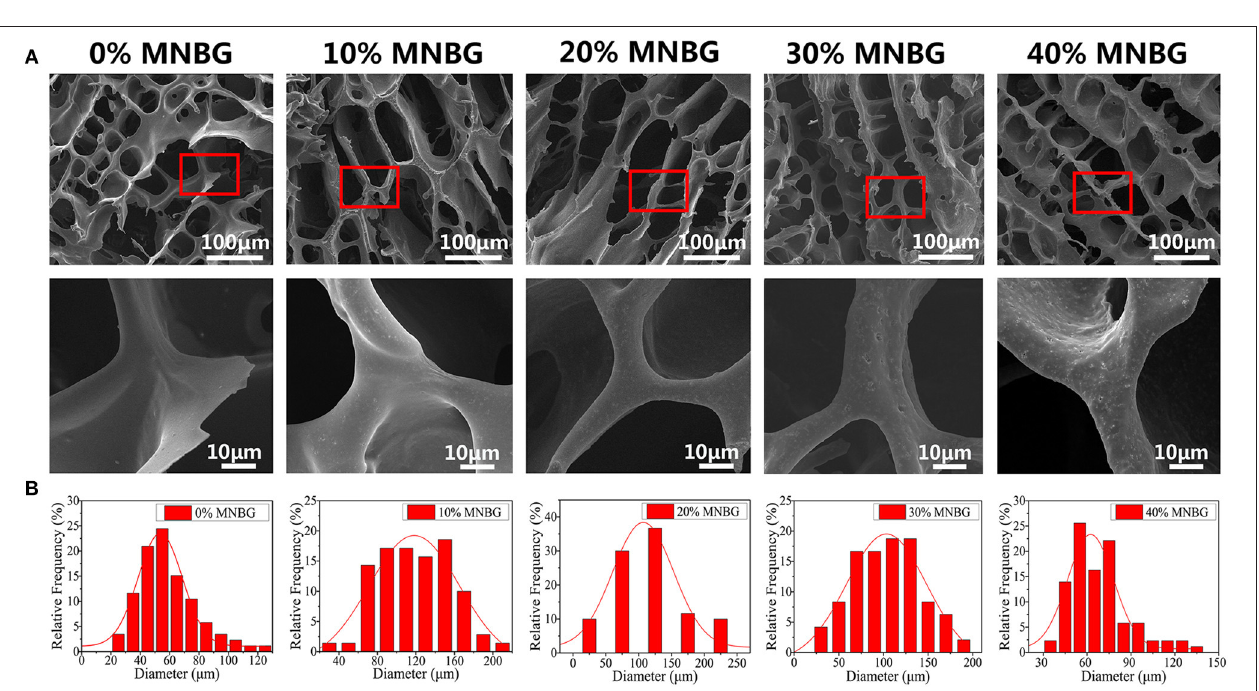
FIGURE 2 | Characterizations of PLGA-MNBG scaffold. (A) SEM image showing the porous structure of composite scaffolds. (B) Pores diameter distribution of different composition of PLGA-MNBG scaffolds.